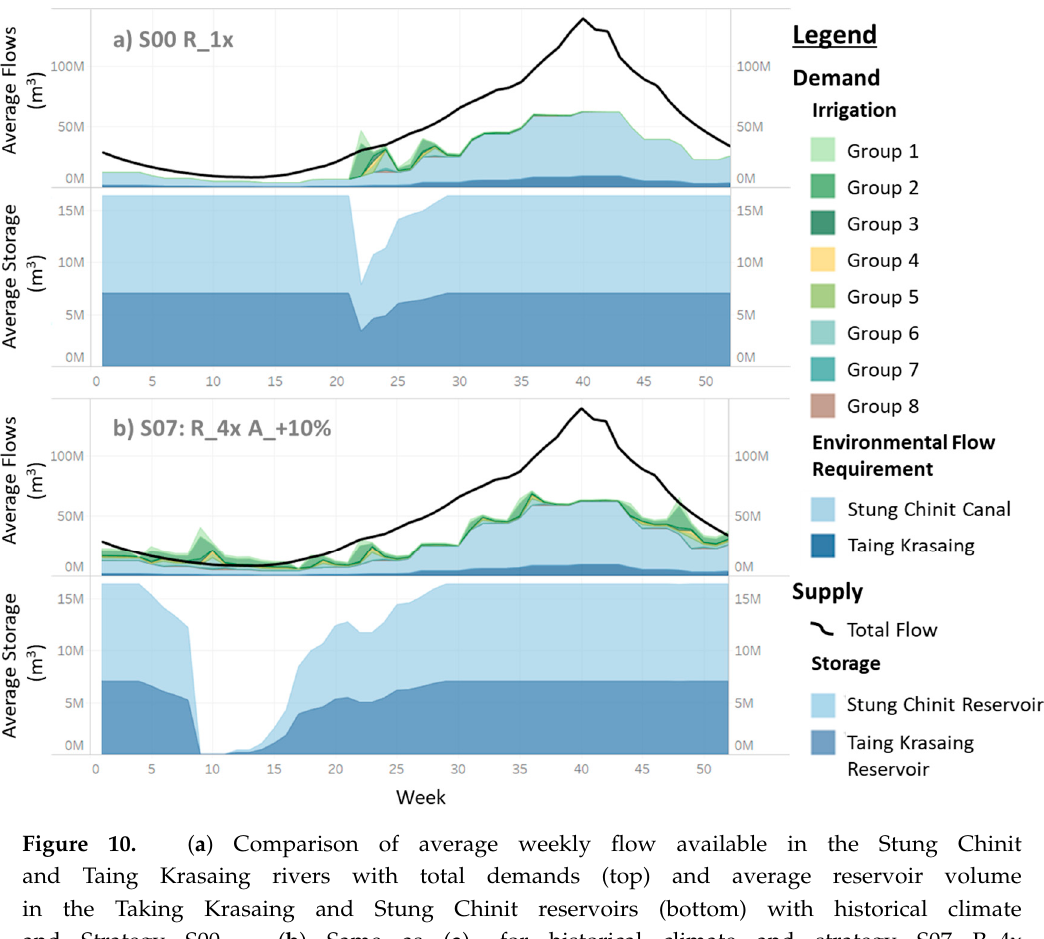
Figure 10. ( a ) Comparison of average weekly flow available in the Stung Chinit and Taing Krasaing rivers with total demands (top) and average reservoir volume in the Taking Krasaing and Stung Chinit reservoirs (bottom) with historical climate and Strategy S00. ( b ) Same as ( a ), for historical climate and strategy S07 R_4x A_+10%. An interactive graphic with all strategies and climate scenarios